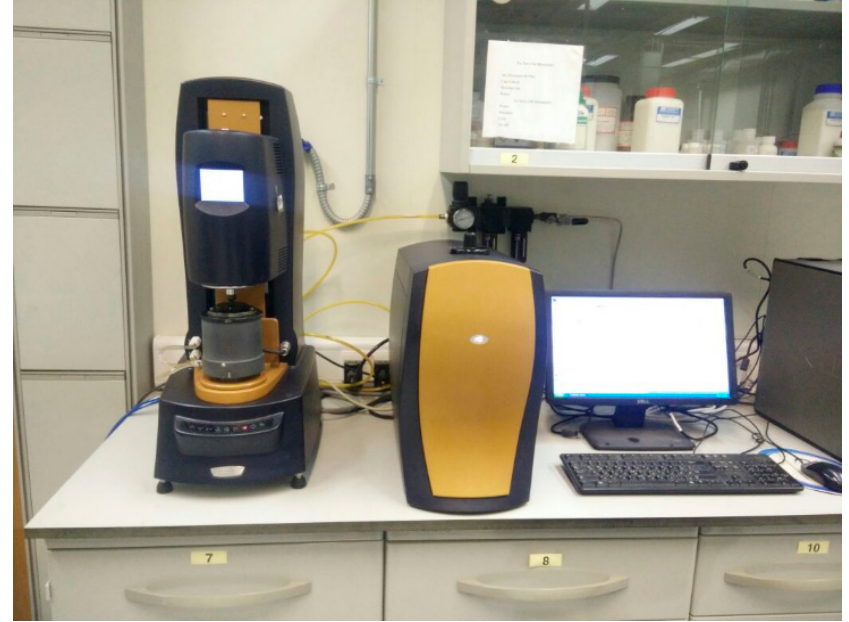
Figure 3. Discovery hybrid rheometer.